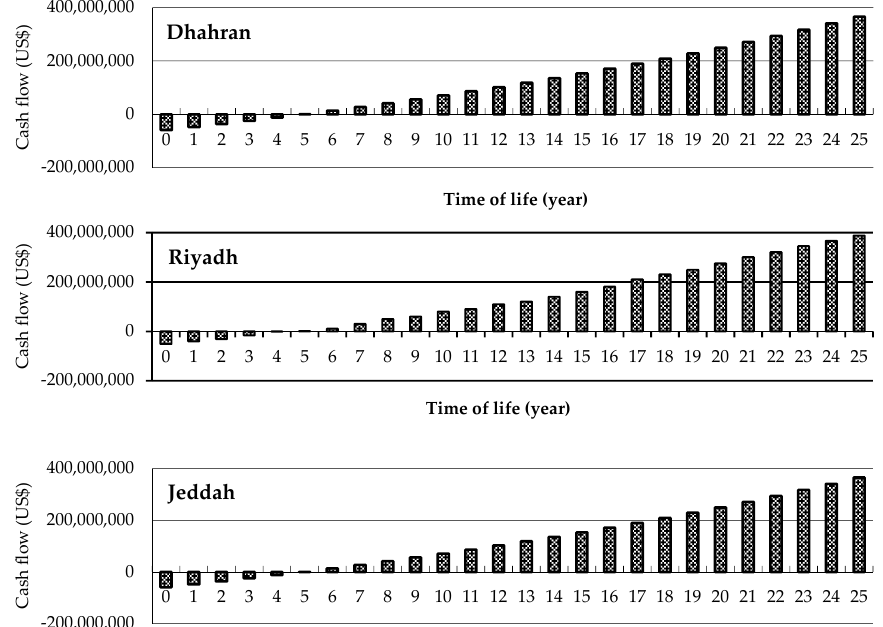
Figure 12. Achieved capacity factor for all sites. The discount rate for feasibility of renewable based power technologies in KSA is normally taken as 0% [41] which is the case in this paper as well. The interest rates, project life time, and other related financial parameters are illustrated in Table 4. Figure 13 provides an overview of the cash flow over the project life time for all sites. The cash flow indicates that the investor is expected to get a positive cash flow from the 5th year onwards for all sites. Based on this cash flow, simple payback periods of 5.9, 6.3, 6.2, 6.2, and 6.7 years are expected for Dhahran, Riyadh, Jeddah, Guriat, and Nejran, respectively (Figure 14). A minimum equity payback of 4.4 years is observed for Dhahran. Similarly, Figure 15 illustrates the results obtained for IRR assets and equity. Average values of 23 and 18% are observed for IRR assets and equity, respectively, for all sites. All the financial indicators show that the proposed systems seem to be economically feasible. Table 4. Financial parameters. Factor